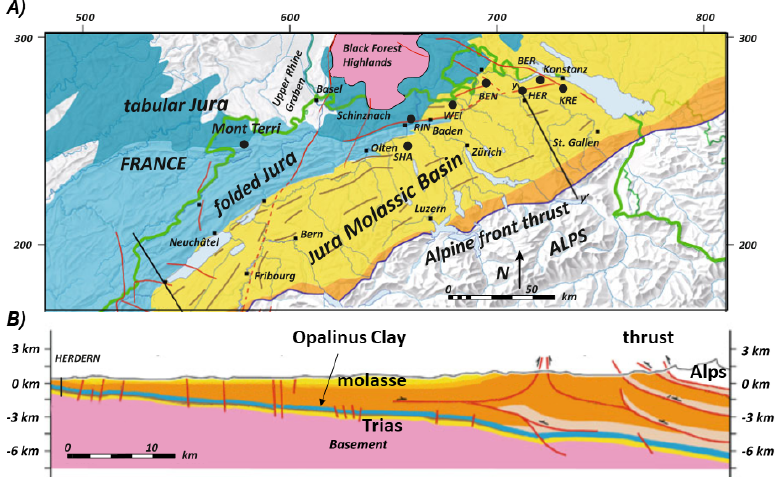
Figure 5. Location of boreholes from which Opalinus Clay was sampled. ( A ) Map view; coordinates are on the Swiss km grid. ( B ) Cross-section; the Herdern borehole location is indicated. Map and geological cross-section adapted from [27].